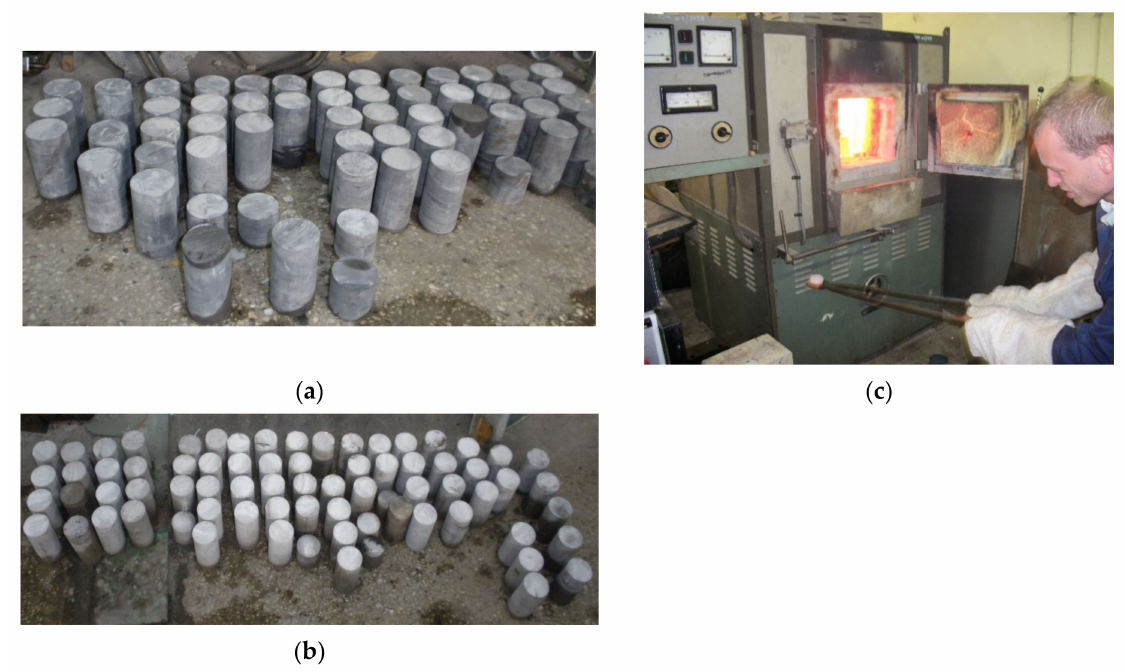
Figure 2. Preparation for tests: ( a ) regular samples of claystone; ( b ) regular samples of sandstone; ( c ) heating in a laboratory